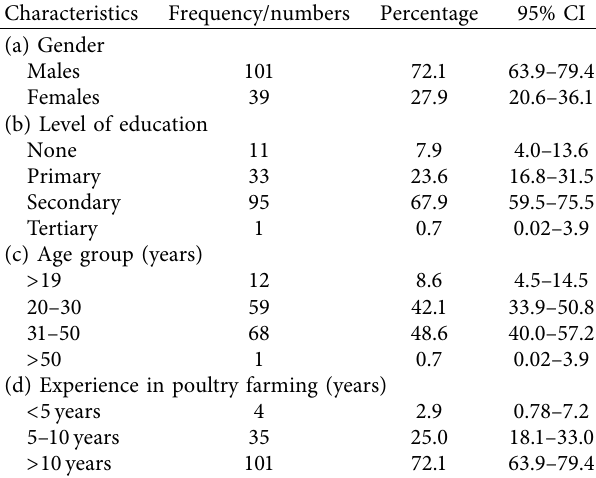
Table 1: Characteristics of